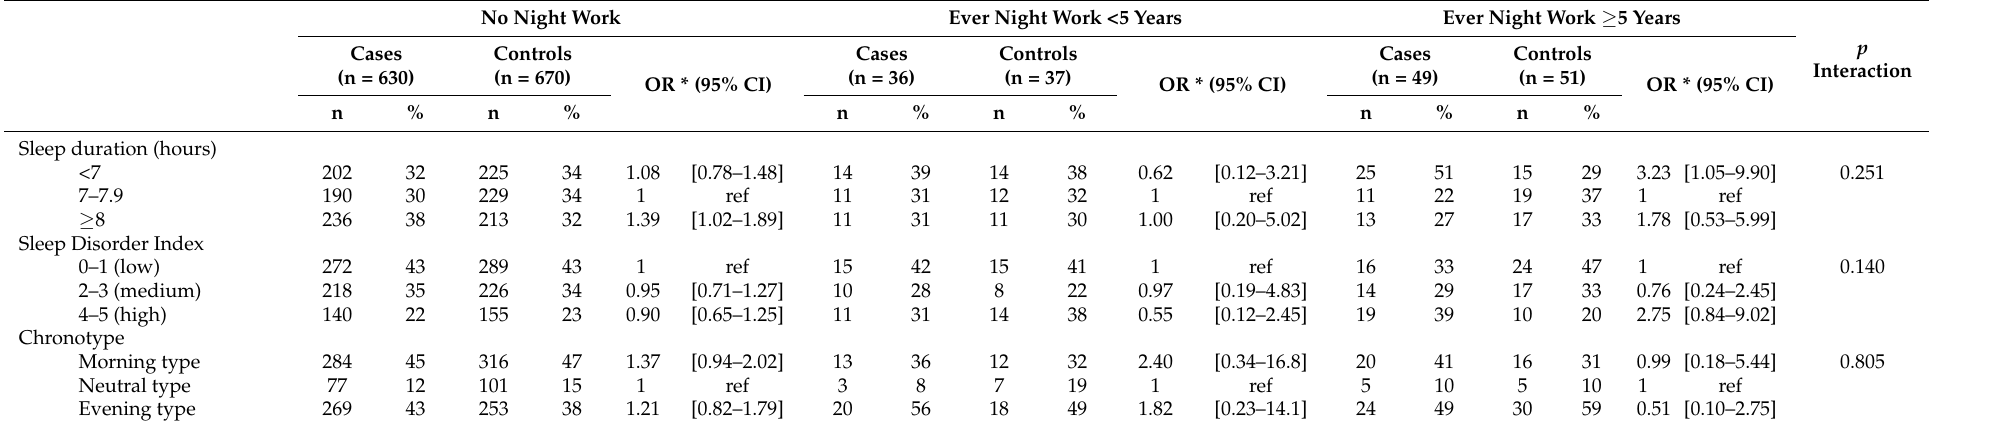
Table 4. Association between sleep traits, chronotype and lung cancer according to night